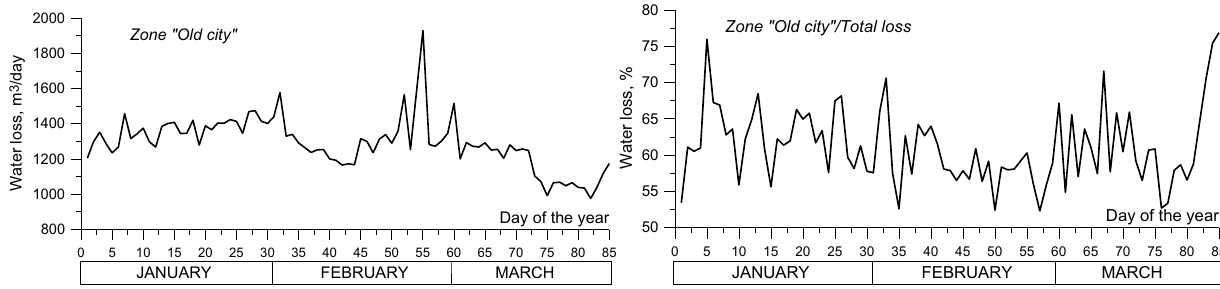
Fig. 5 Water losses in the “Old city” zone, in m 3 (left), as percentage ( δ